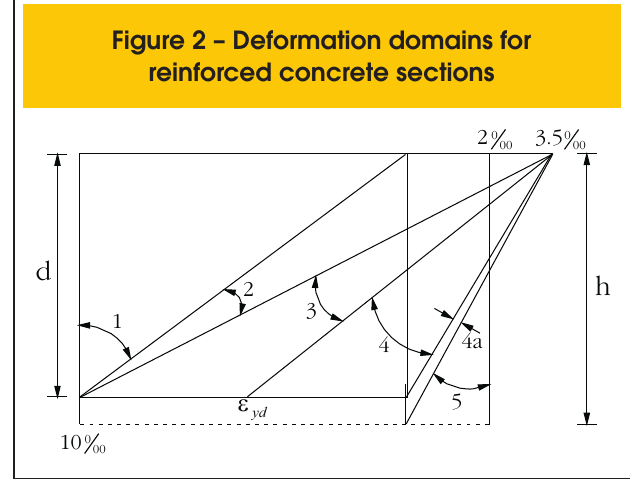
Figure 2 – Deformation domains for reinforced concrete